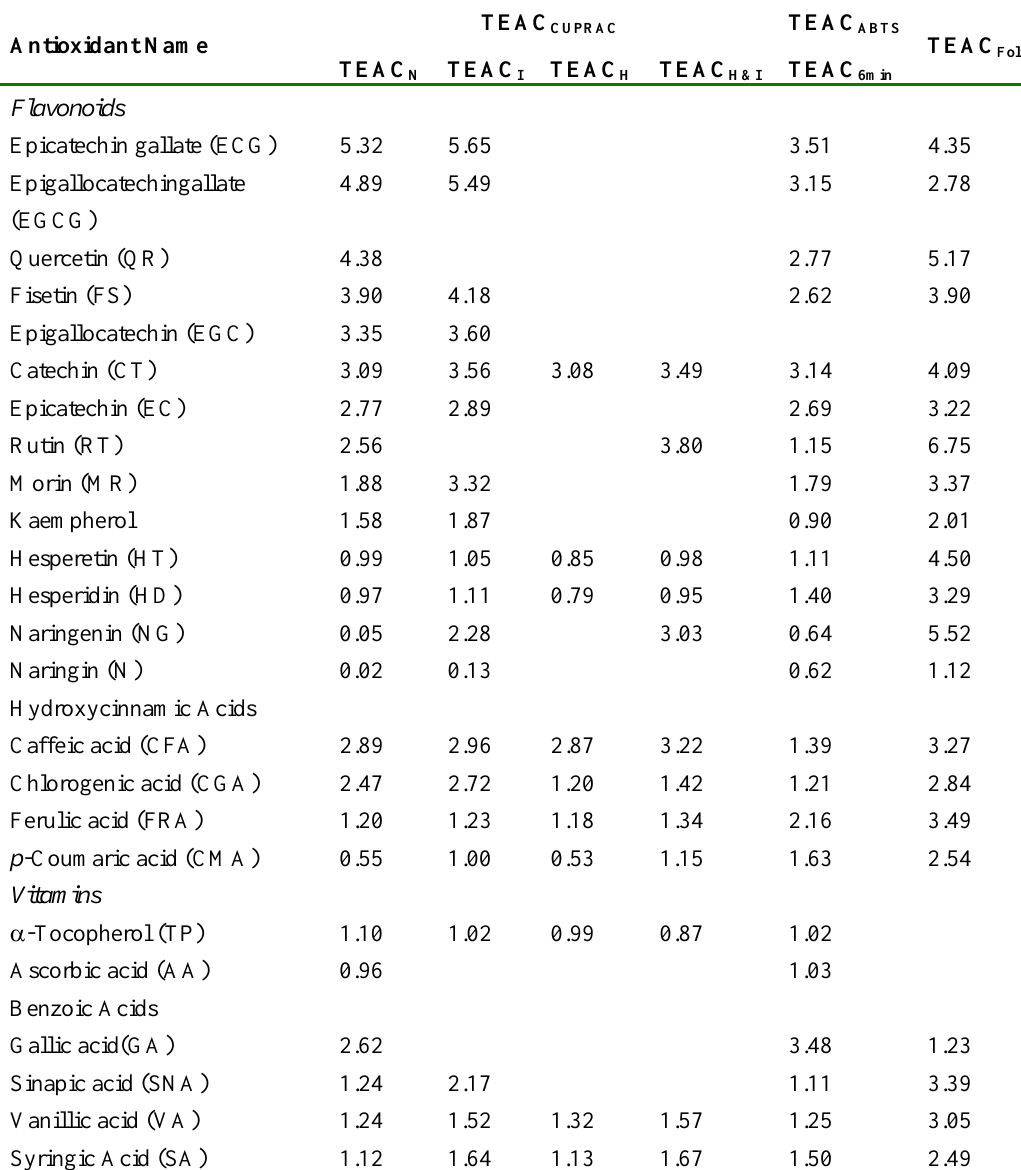
Table 3. Antioxidant capacities of the polyphenolic compounds (in the units of TEAC: Trolox ® equivalent antioxidant capacity) as measured by CUPRAC, ABTS/persulfate, Folin, FRAP, Ferricyanide, Fe(III)-phenanthroline, and Ce(IV)